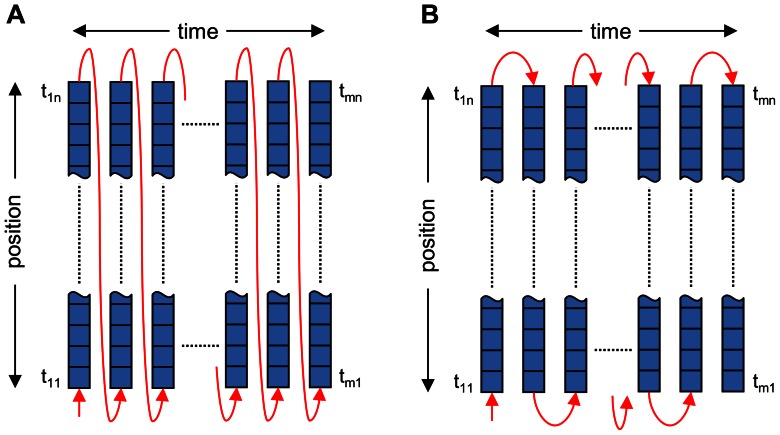
The temporal sequence of pixels in an image acquired in the x-t line scan mode.Panels A and B describe the unidirectional and the bidirectional mode, respectively, as rendered in the confocal image, that is, each pixel in a line is assigned the same acquisition time. In fact, each subsequent pixel is shifted along the time axis by the value of the pixel integration time, and each line is shifted by the scanner reversal time. Red arrows indicate oscillations of the scanner. The squares represent the acquired pixels of the confocal image; tij is the time of acquisition of the pixel in the ith column and jth row of the image (i = 1 … m, j = 1 … n), described by Eq. 3 or Eq. 4 for the unidirectional or the bidirectional mode.